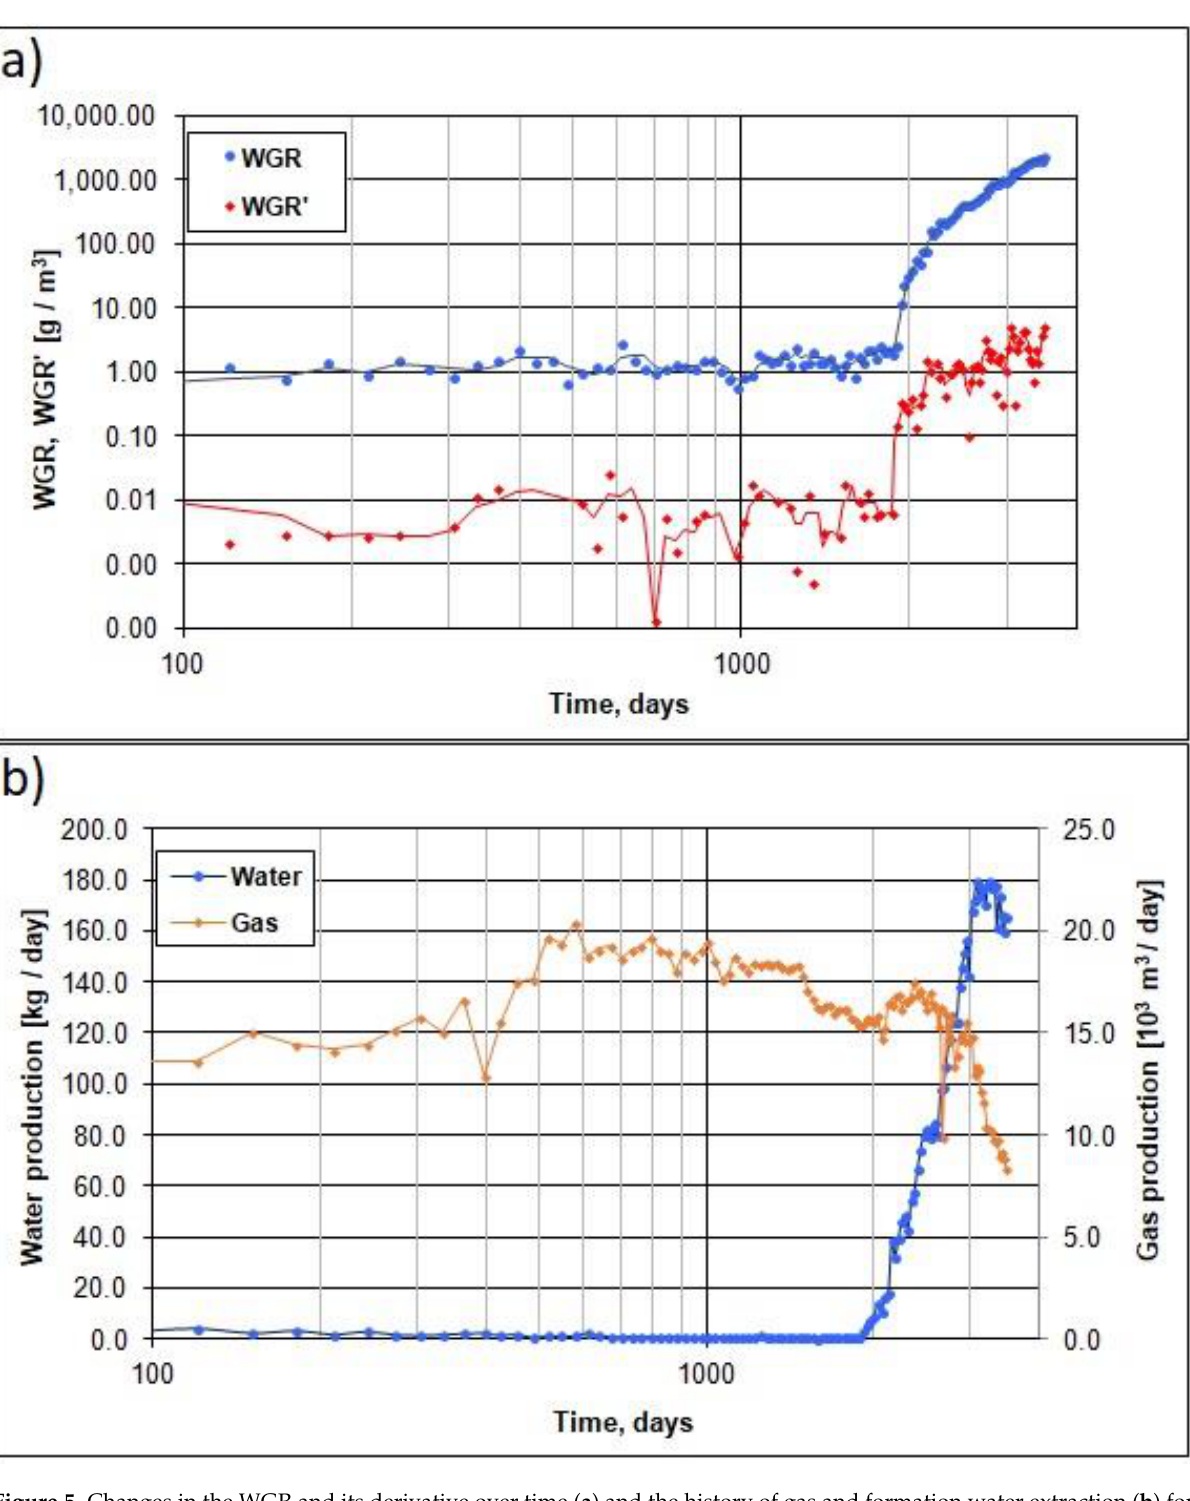
Figure 5. Changes in the WGR and its derivative over time ( a ) and the history of gas and formation water extraction ( b ) for the P-6